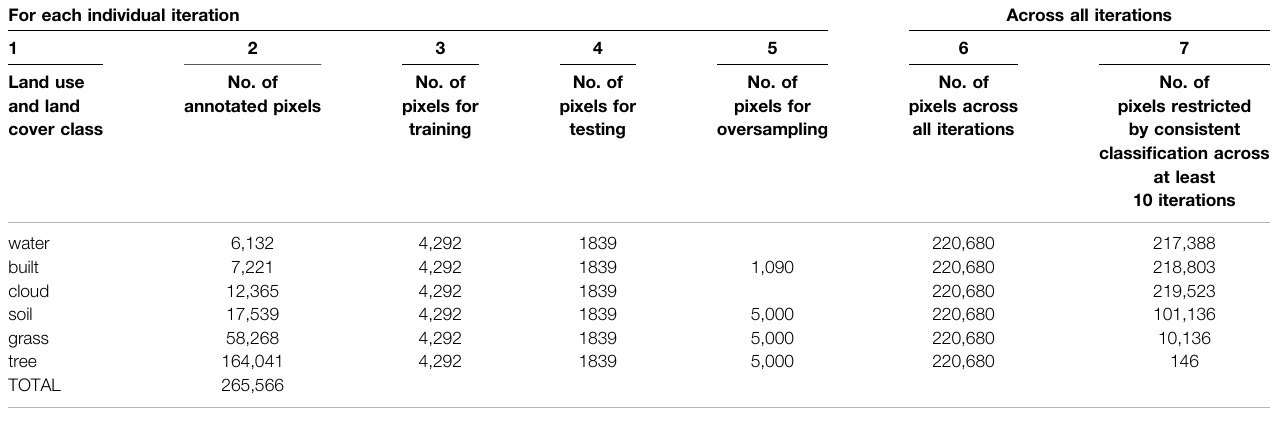
TABLE 2| WedevelopedaModel Ensemblebasedon120iterations oftheRandom Forest algorithmonourannotated dataset. Wesampledandmanuallyclassi fi ed2.65 × 10 5 pixels.Foreachiteration,pixelnumbersfortraining,testing,andoversamplingarelistedincolumns3through5.Toevaluatetheaccuracyofourmodelensemble,we developed Confusion Matrices for two types of test data. In column 6, we combined all test results across all iterations. In column 7, we selected only those pixels that were classi fi ed consistently across at least 10 iterations. For each individual iteration Across all iterations